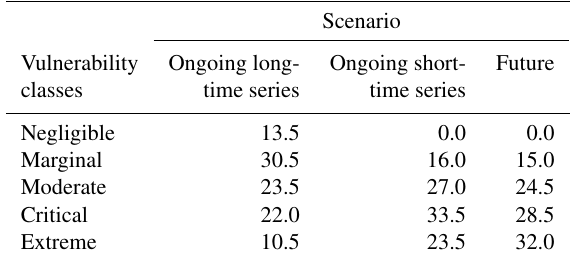
Table 3. Percentages of the Po delta area in each class of the CVI under the three scenarios.